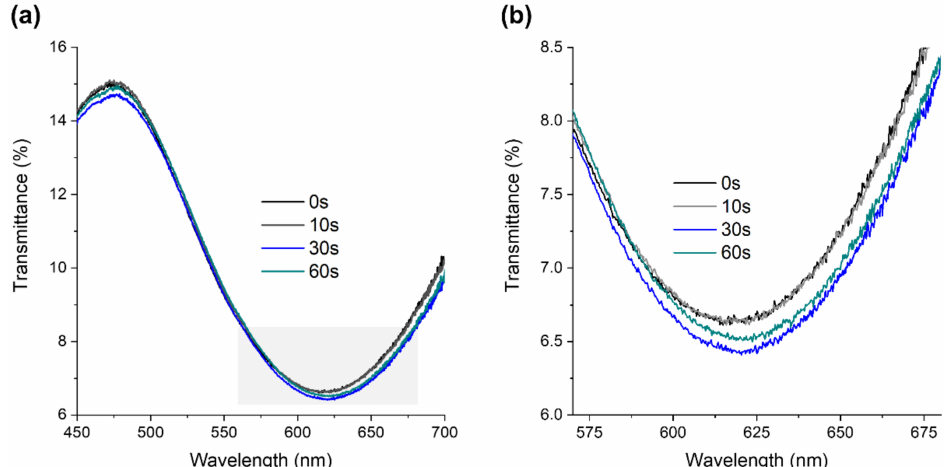
Figure 3. LSPR band evolution as a function of O 2 plasma treatment time (0, 10, 30, and 60 s) of the Au-TiO 2 thin film annealed at 400 ◦ C: ( a ) transmittance spectra from 450 to 700 nm and ( b ) close-up of the highlighted area in graph a.